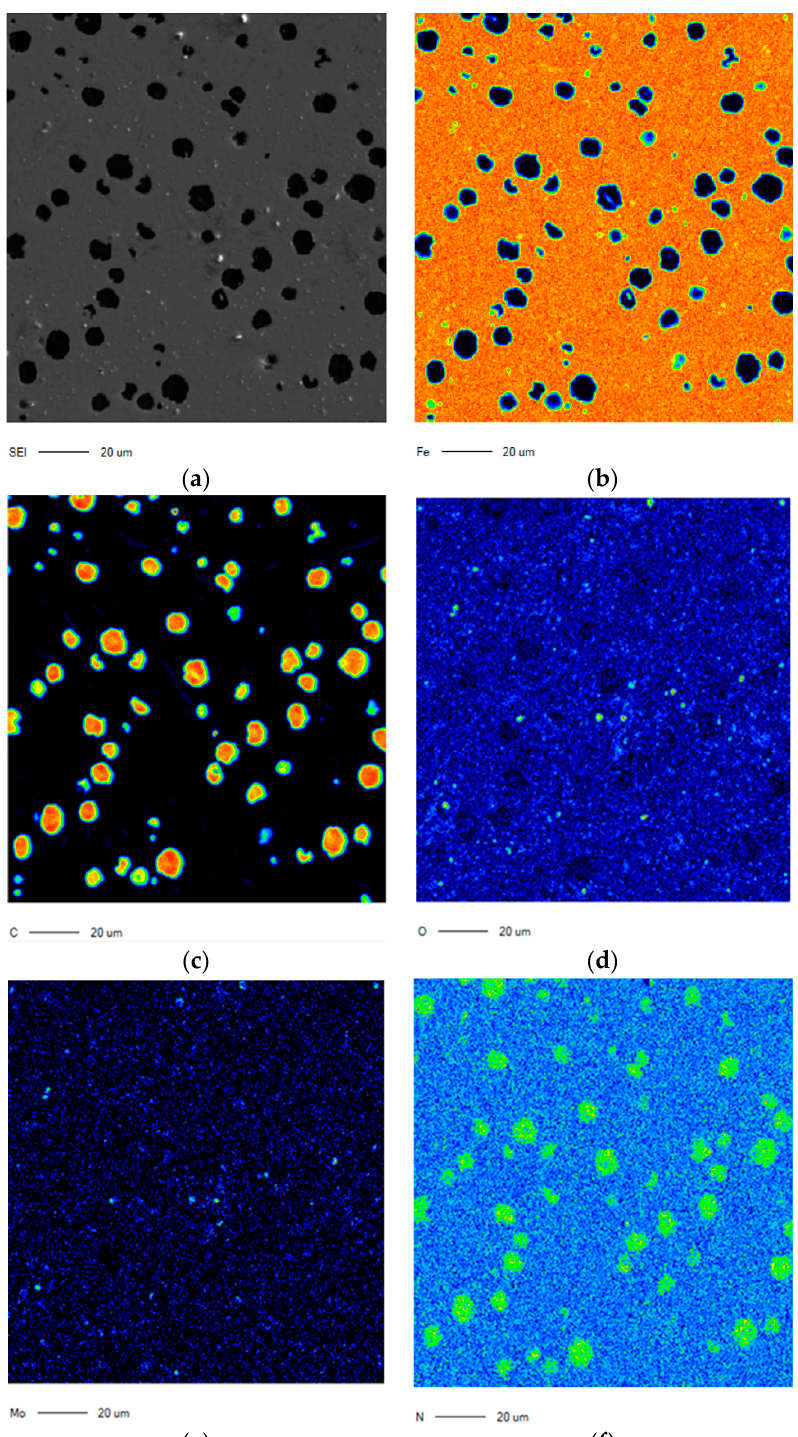
Figure 12. Elemental distribution analyzed by EPMA on the surface of DCI passivated for 72 h in tap water with 1.5 k ppm molybdate + 1 k ppm MEA at room temperature. ( a ) SEM image, ( b ) Fe, ( c ) C, ( d ) O, ( e ) Mo, ( f ) N.